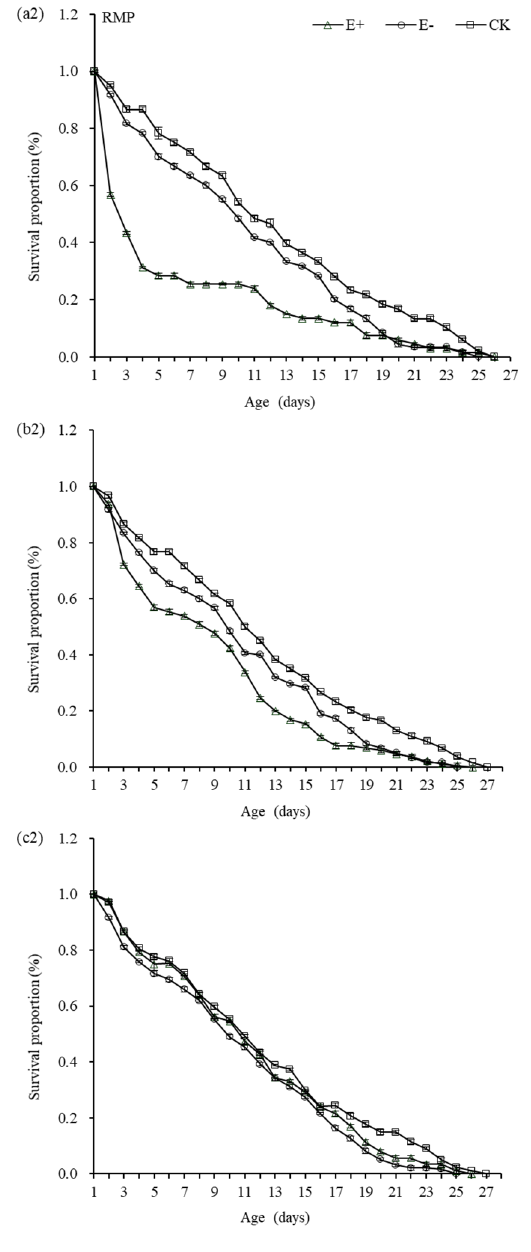
Figure 5. Survival proportion in green color morphs of pea aphids (GMP) and red color morphs of pea aphids (RMP) treated with aqueous extracts different growth periods(seeding stage, a1 , a2 ; maturity, b1 , b2 ; yelowing stage, c1 , c2 ). E+, endophyte-infected A. inebrians ; E − , endophyte-free A. inebrians ; CK, control.